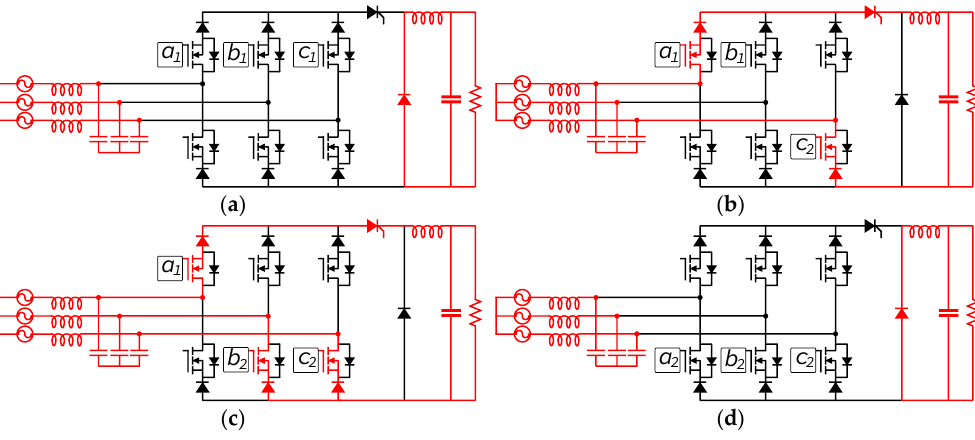
Figure 7. Operating modes: ( a ) Mode 1 (t0-t1, off-state), ( b ) Mode 2 (t1-t2, on-state), ( c ) Mode 3 (t2-t3, on-state), ( d ) Mode 4 (t3-t4, off-state).